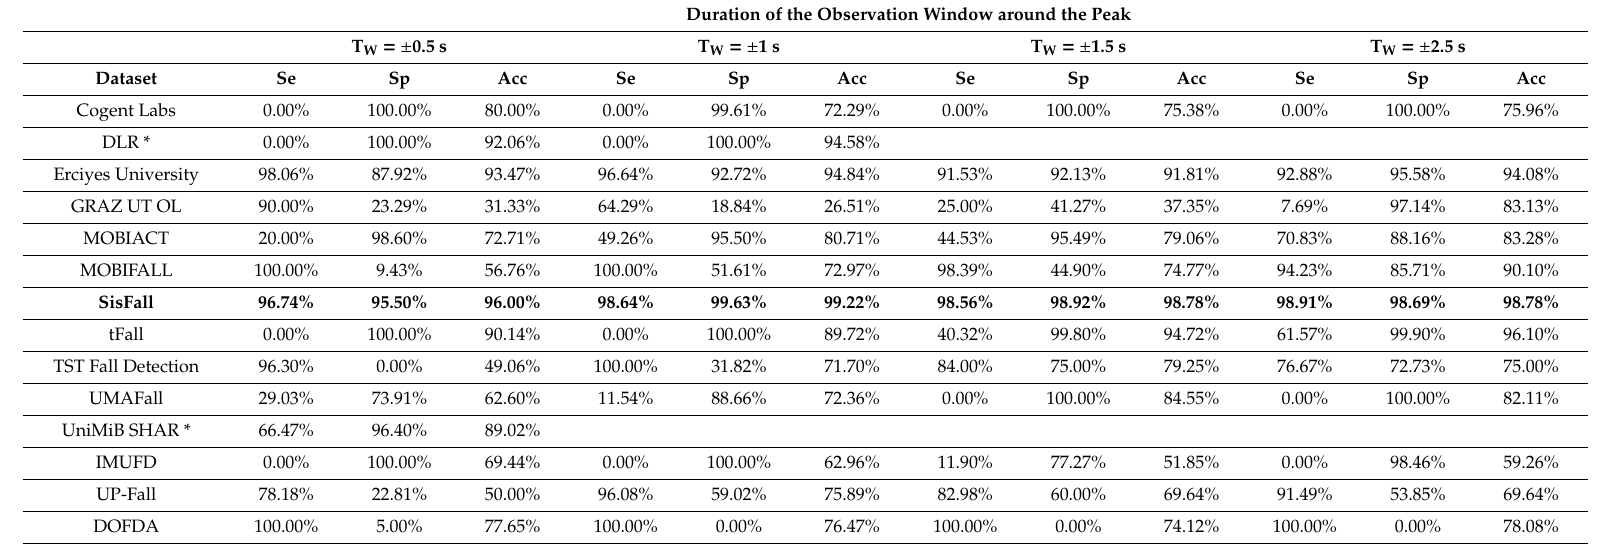
Table 8. Comparison of the obtained performance metrics for the 14 datasets and the four di ff erent observation windows ( T w ) around the peak when the triaxial components of the acceleration magnitude were used to feed the convolutional neural network. (the results for the reference dataset -SisFall- are marked in bold). Note: * Some observation windows could not be applied to these datasets due to the short duration of the